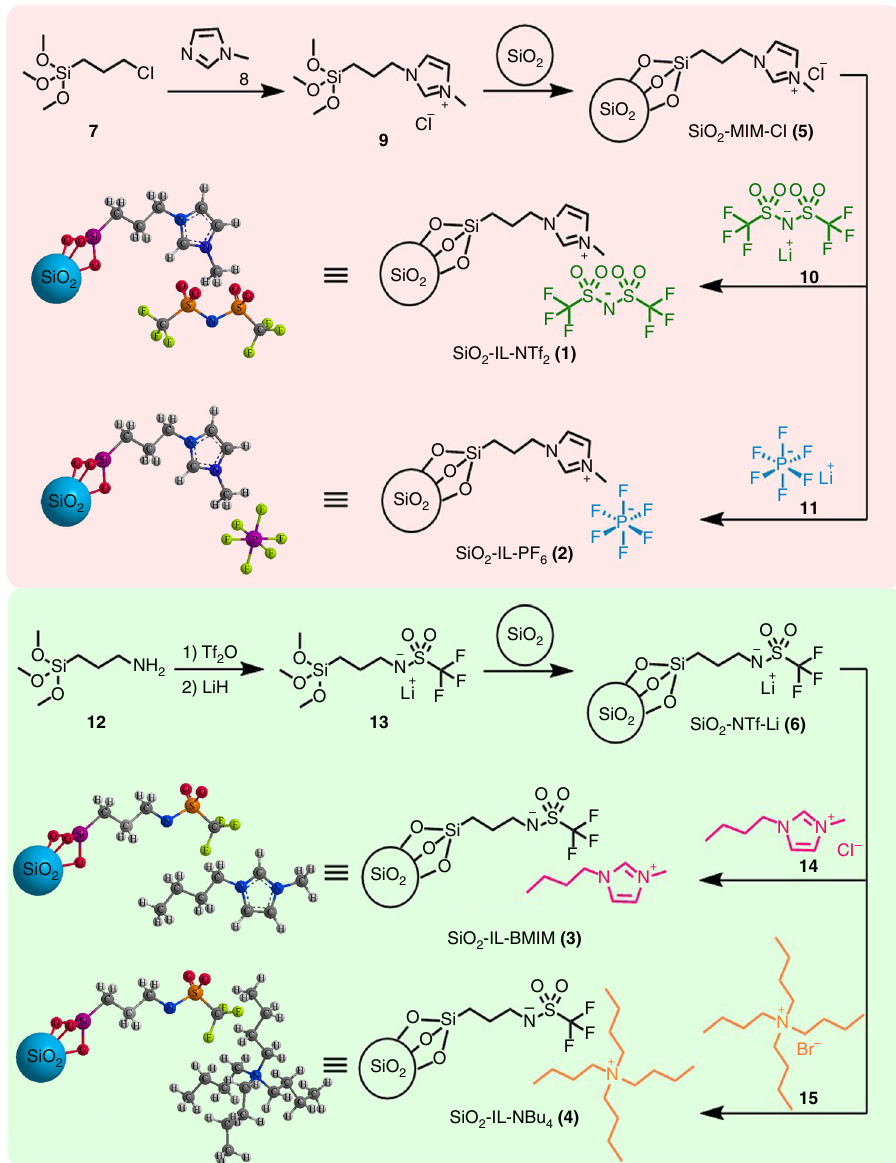
Fig. 2 Synthesis of four silica nanoparticle-grafted ionic liquids (SiO 2 -grafted ILs). Methyl imidazolium cation (MIM + ) and tri fl uoromethanesulfonyl imide anion (NTf − ) were fi rstly covalently grafted to silica nanoparticles to synthesize the key intermediate products SiO 2 -MIM + and SiO 2 -NTf − . Synthetic SiO 2 - MIM + was combined either with bis(tri fl uoromethanesulfonyl) imide (NTf 2 − ) or hexa fl uorophosphate (PF 6 − ), and synthetic SiO 2 -NTf − was combined with either 1-butyl-3-methylimidazolium (BMIM + ) and tetrabutylammonium (NBu 4 + ) through ion exchange to obtain SiO 2 -IL-NTf 2 ( 1 ), SiO 2 -IL-PF 6 ( 2 ), SiO 2 -IL- BMIM ( 3 ), and SiO 2 -IL-NBu 4 ( 4